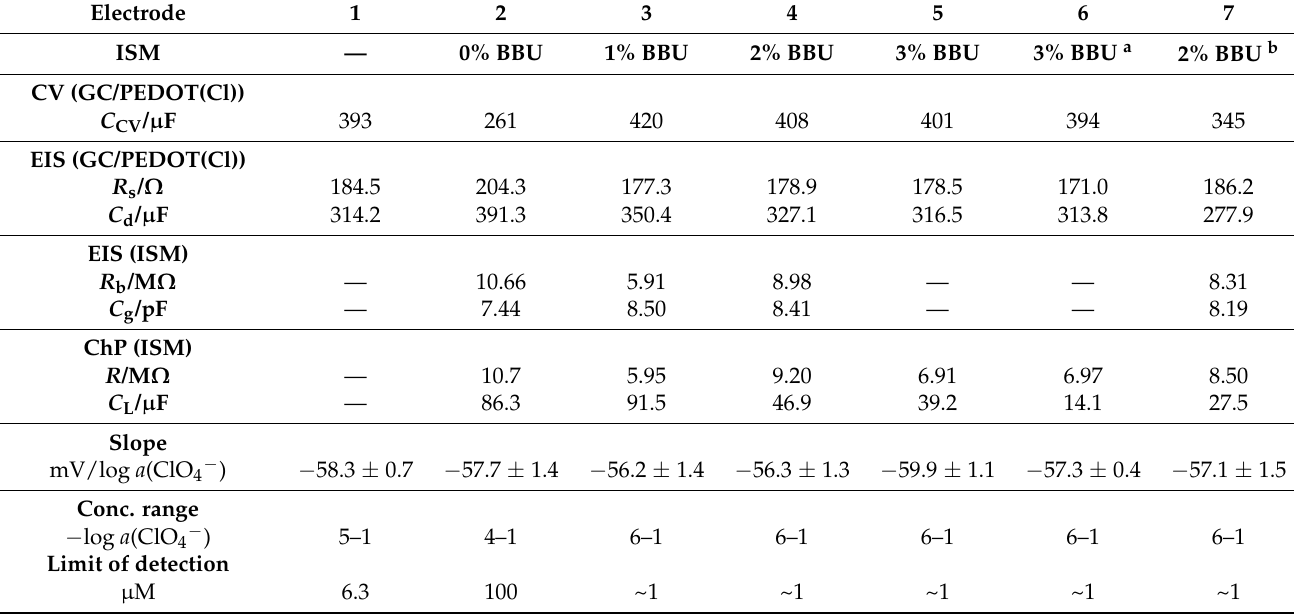
Table 2. The characteristic electrical parameters of the ISM layer and metrological parameters of ISE.